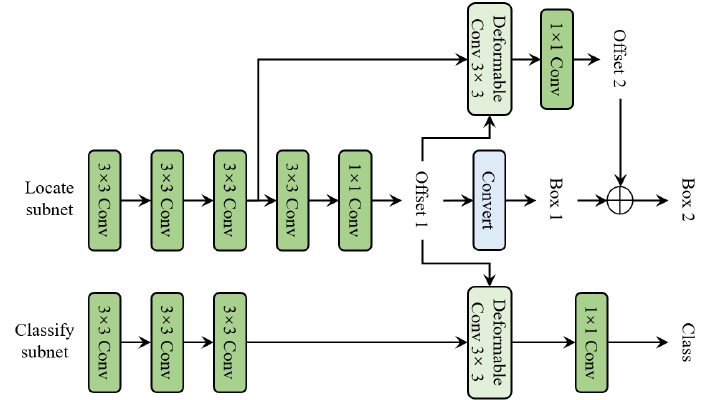
Figure 12. The pipeline of detection